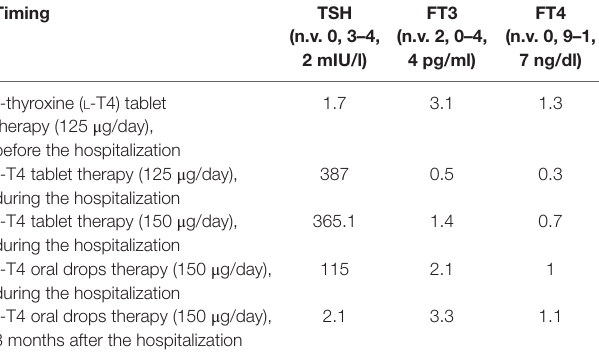
taBLe 1 | Thyroid laboratory values before, during, and after the hospitalization.